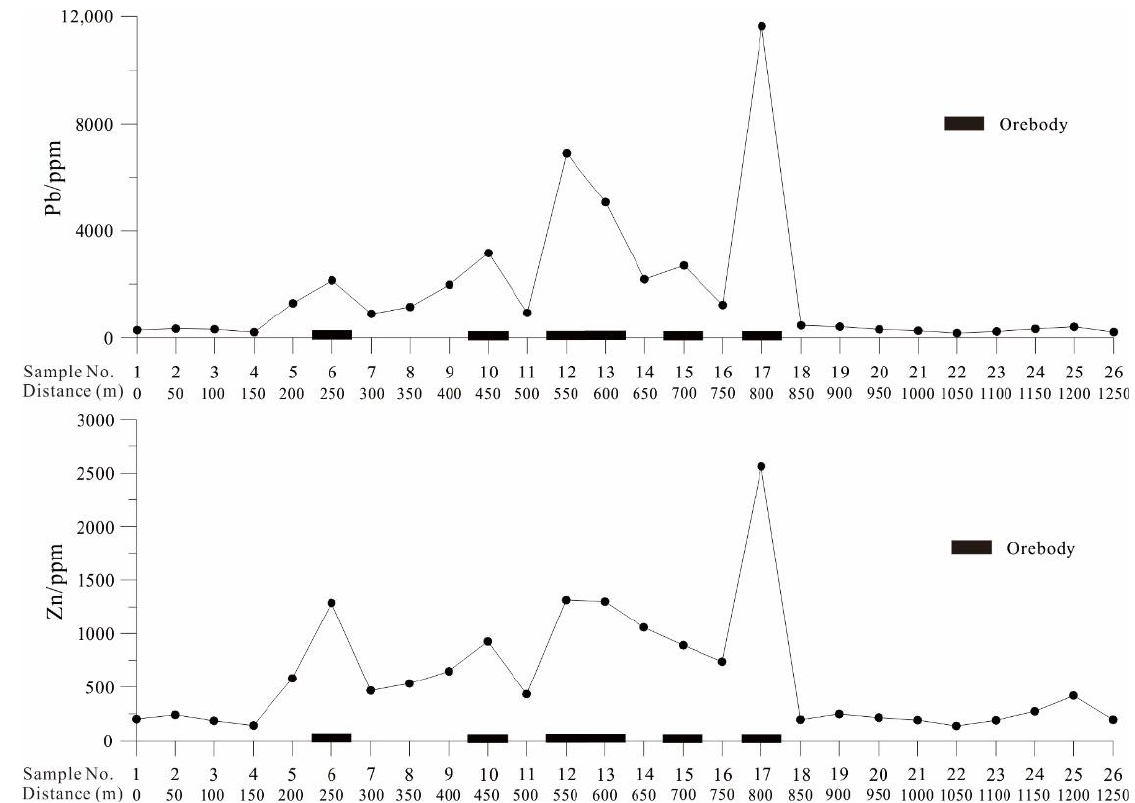
Figure 6. The sample No. 17 (800 m) above the ore body contains the highest Pb content, 11,637 ppm, which is about 40 times the Pb content in the background area (about 300 ppm in sample No. 1–4, and No. 20–26). The second highest Pb content is 6891 ppm (Sample No. 12), which also appeared above the ore body (550 m) and is about 20 times that in the background area. Similarly, other high Pb content values also appear above the ore body. A similar distribution is also observed with Zn. These results demonstrate that using the fine fraction of soil can indicate Pb and Zn mineralization in arid Gobi Desert covered areas.